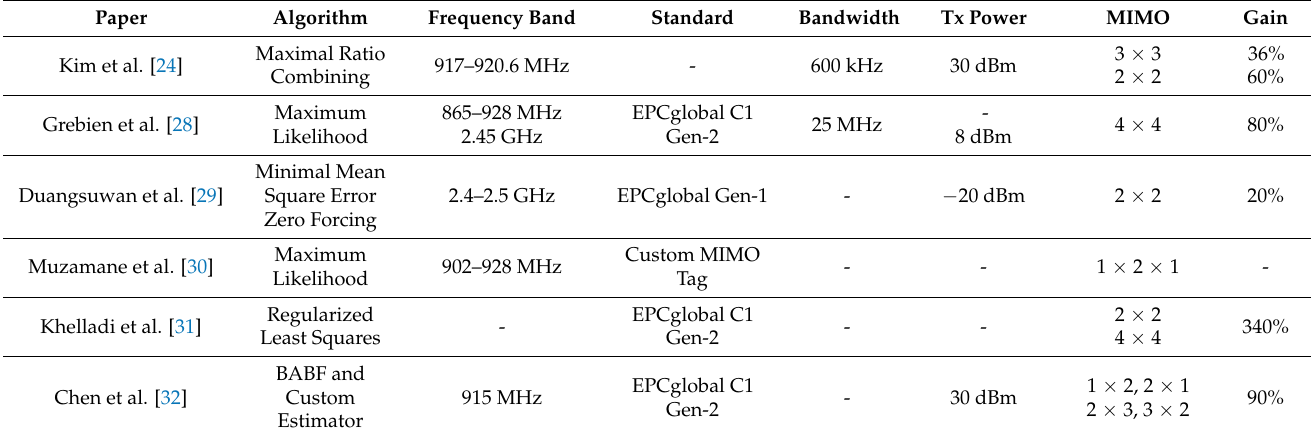
Table 1. Comparison of various estimation